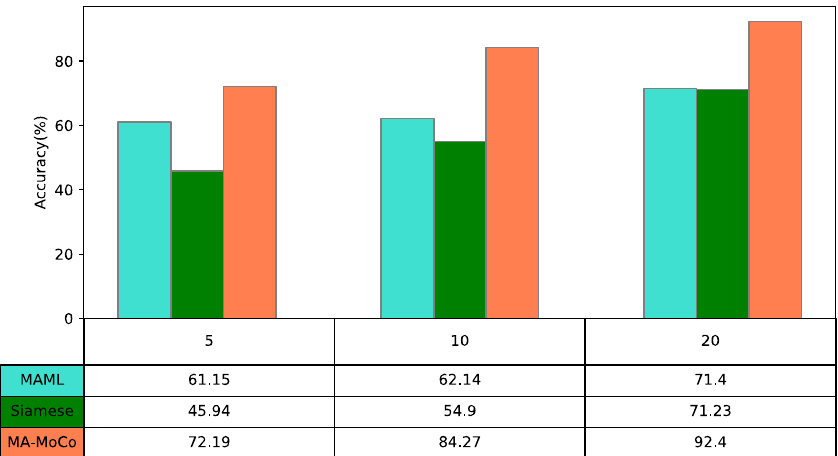
Figure 6. A 4-way 1-shot diagnosis of the accuracy of the generator bearing data when the training set of each class has 5, 10, and 20 fault samples.